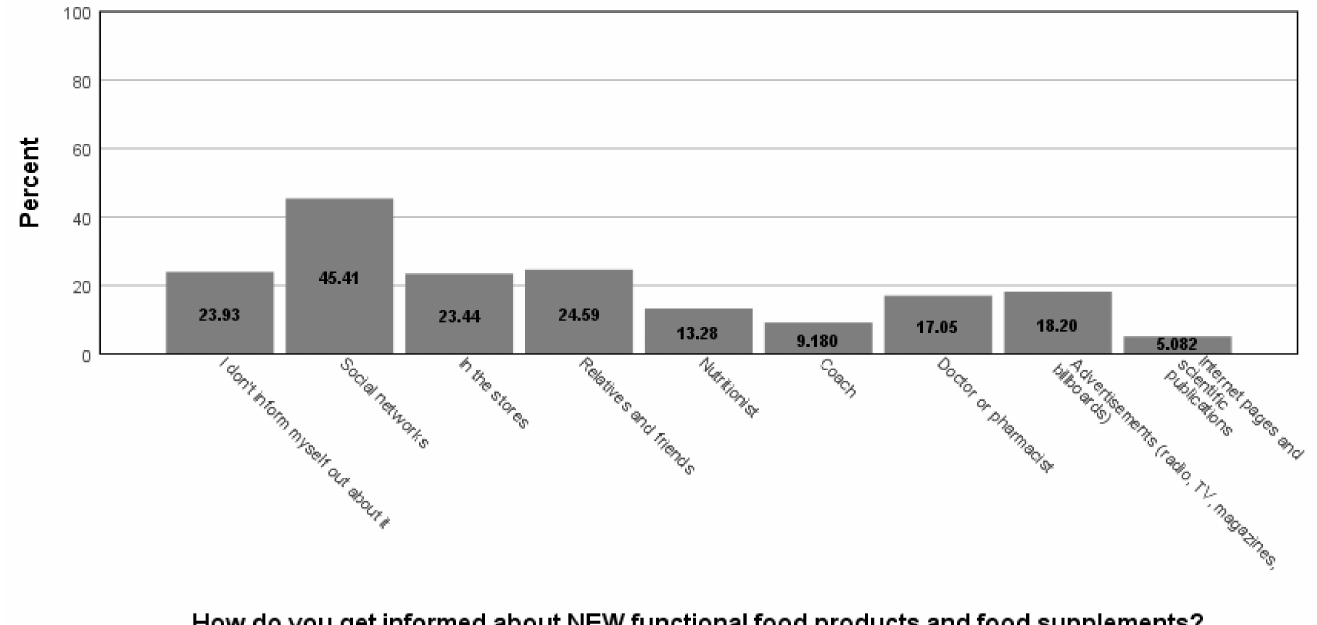
Figure 1. Sources of information about functions of food and dietary supplements.